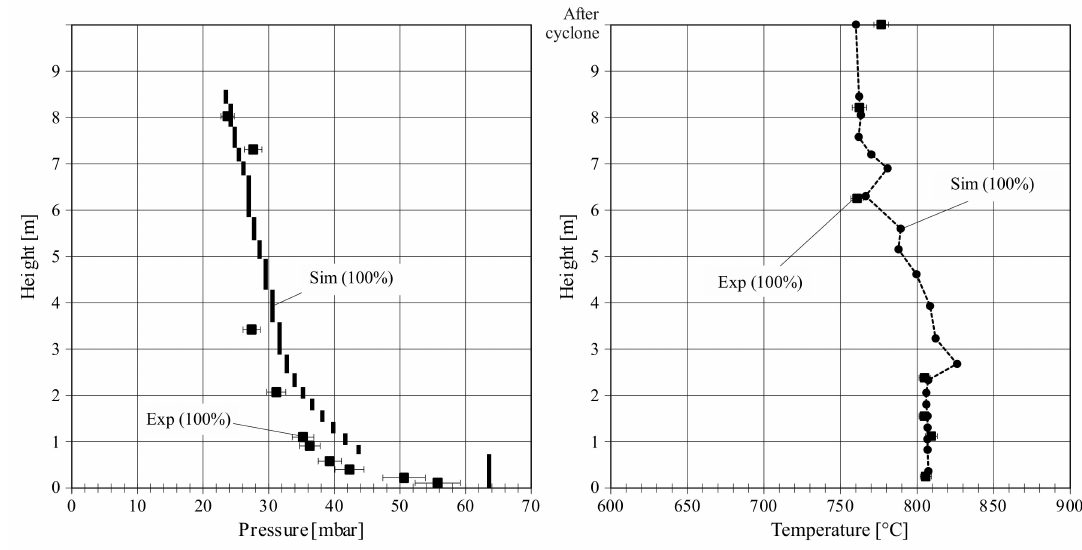
Figure 7. Pressure and temperature along the reactor at high